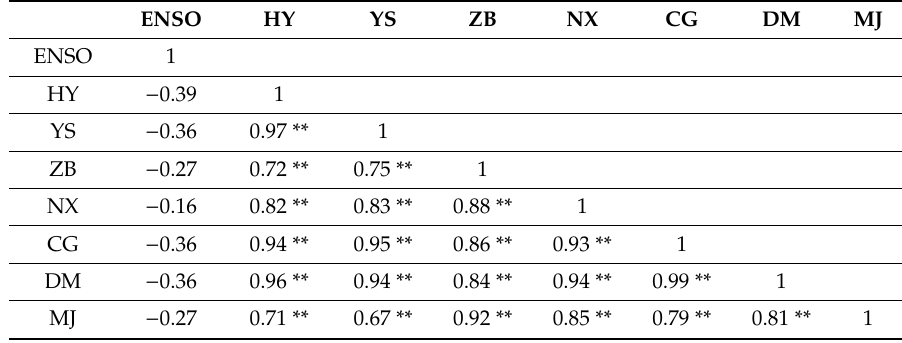
Table 2. Correlation coe ffi cients for ENSO and TC-induced precipitation.